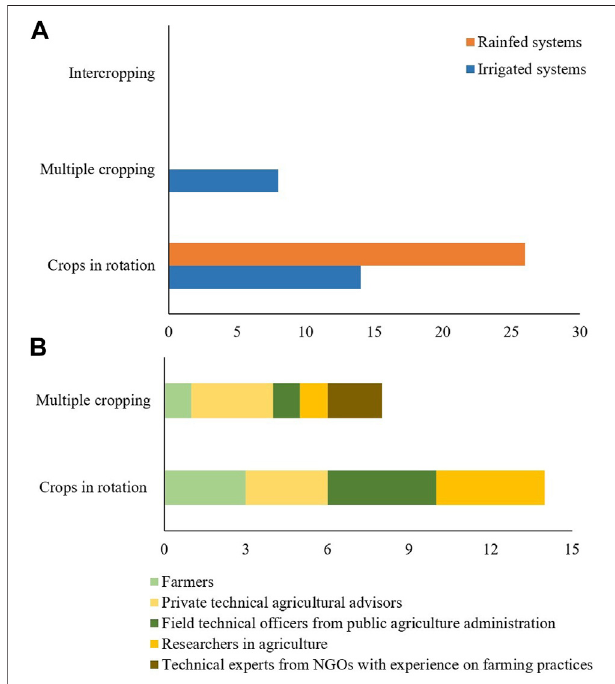
FIGURE 3 | In the Po Valley and Capitanata Plain case study areas, number of consulted stakeholders that identi fi ed each type of crop diversi fi cation strategy as most adequate for both the rainfed and irrigated systems (A) . Number of respondents grouped per type of stakeholders for the irrigated cereal-based cropping systems (B)